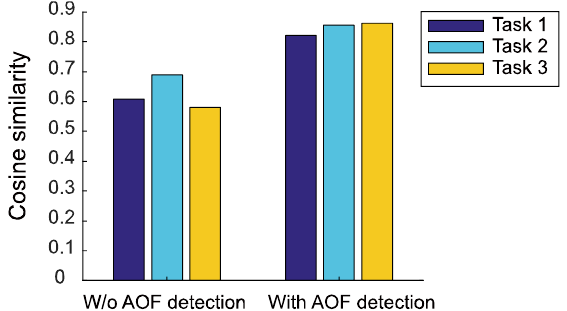
Figure 8. Similarities between task-related attribute values and learned aspects without and with AOF detection